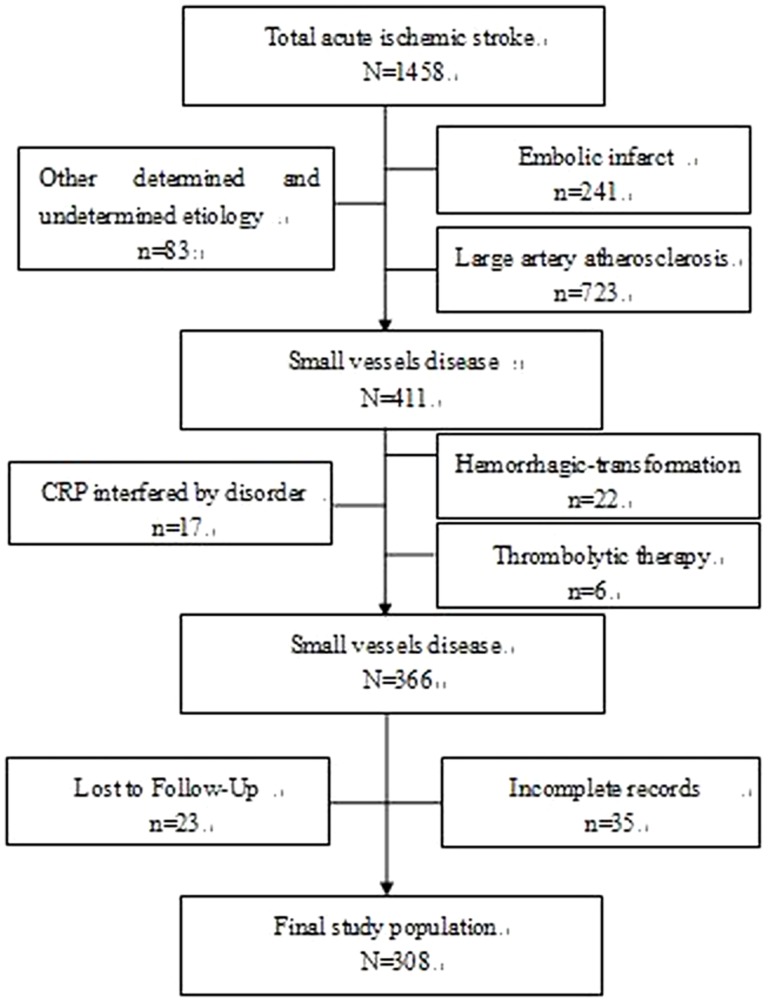
Inclusion and exclusion of subjects.